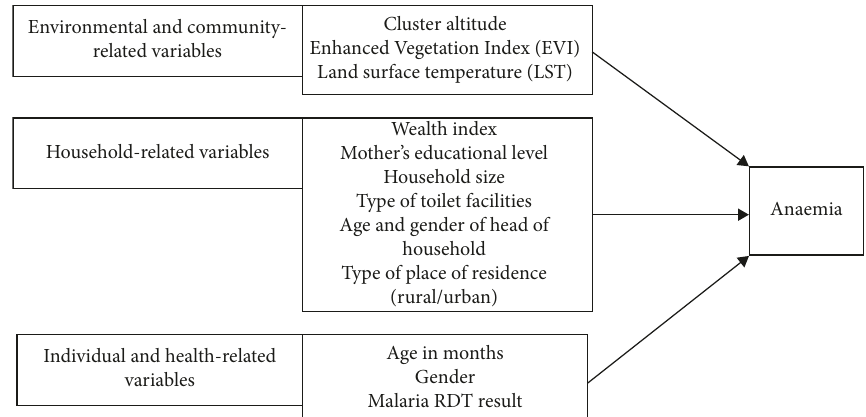
Figure 1: Potential risk factors of childhood